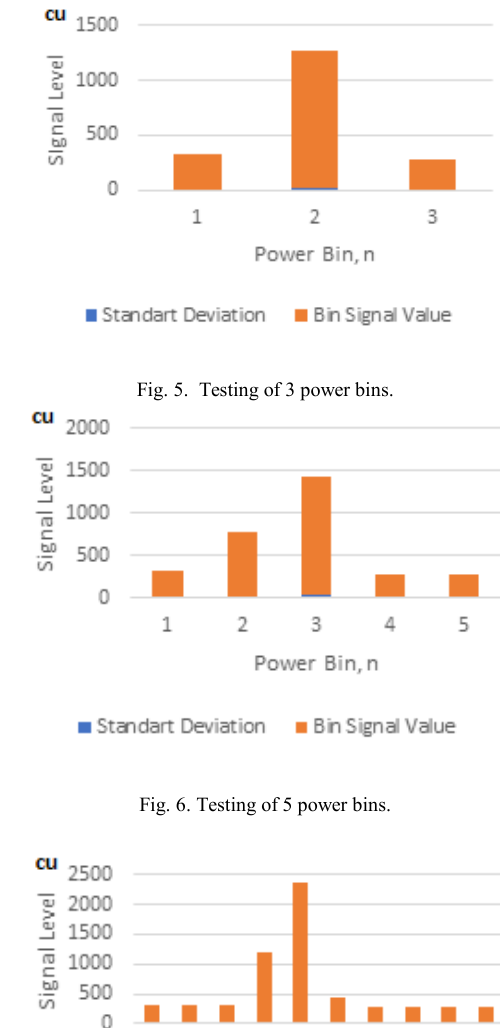
Fig. 5. Testing of 3 power bins.